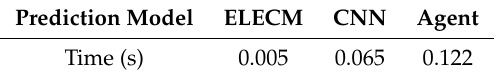
Table 1. Average prediction time on each inclined ship for Eigenvectors with the Largest Eigenvalue of Covariance Matrix (ELECM), Convolutional Neural Network (CNN) direct regression and Agent